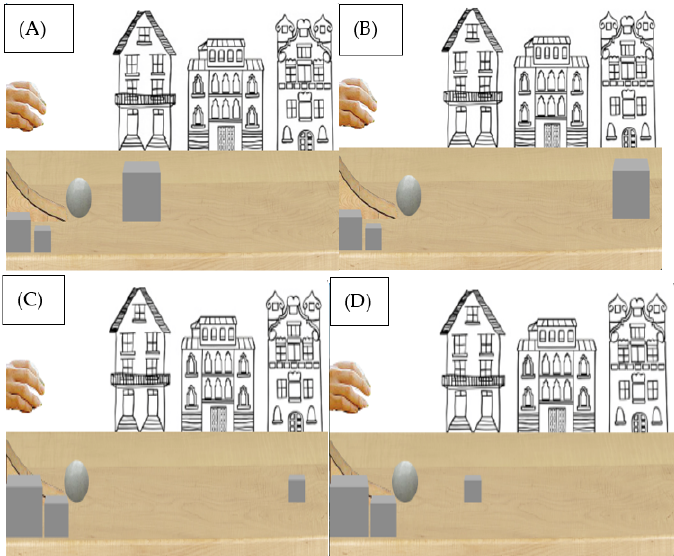
Figure 5. ( A ) Large cube congruent, ( B ) Large cube incongruent, ( C ) Small cube congruent, ( D ) Small cube incongruent test events.